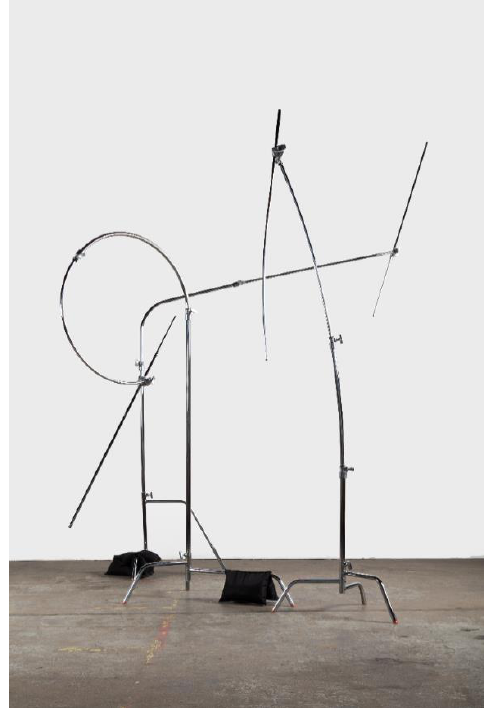
Figure 8. Kerry Tribe, sculptural installation from The Loste Note exhibition at 356 Mission, 2015.